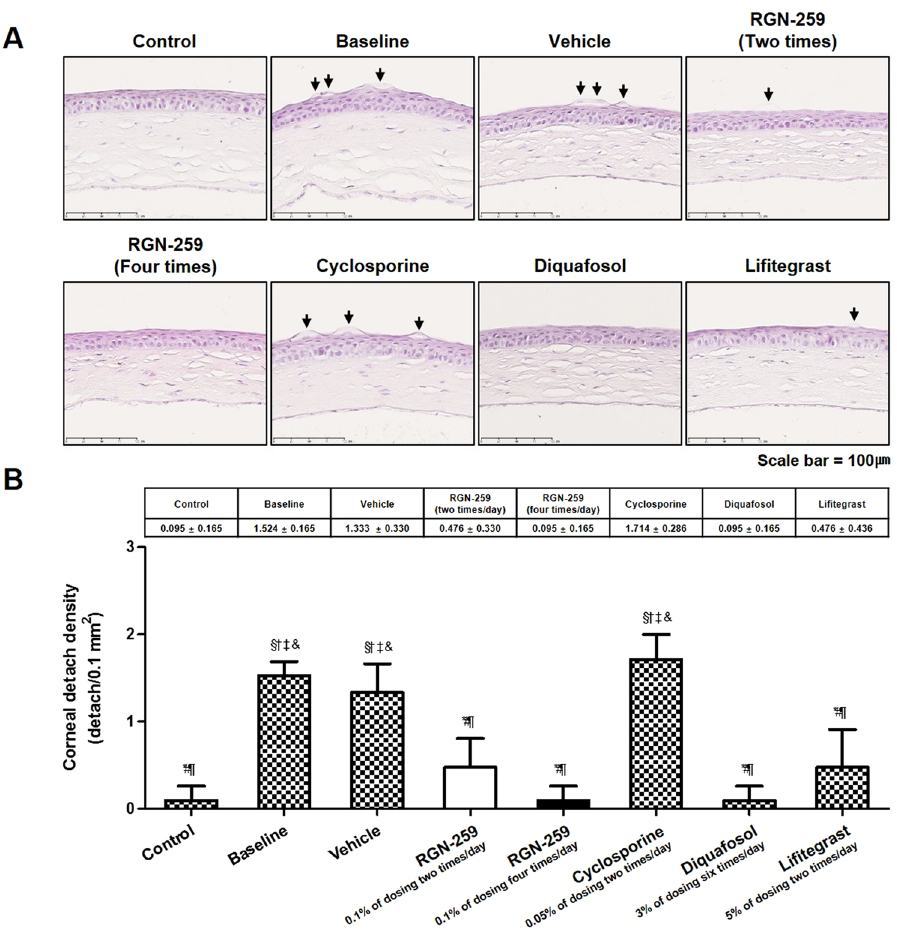
Figure 4. RGN-259 reduced detachment of corneal epithelial cells comparable to that of DQS. ( A ) The sections are stained with hematoxylin-eosin. The arrows indicate the detached corneal epithelial cells. Scale bar = 100 μ m. ( B ) The number of detached corneal epithelial cell. * P < 0.05 vs. the corresponding value in the baseline desiccation stressed group. # P < 0.05 vs. the value in the vehicle-treated group. § P < 0.05 vs. the value in the RGN-259, 2 times per day group. † P < 0.05 vs. the value in the RGN-259, 4 times per day group. ¶ P < 0.05 vs. the value in the CsA group. ‡ P < 0.05 vs. the value in the DQS group. & P < 0.05 vs. the value in the LFA